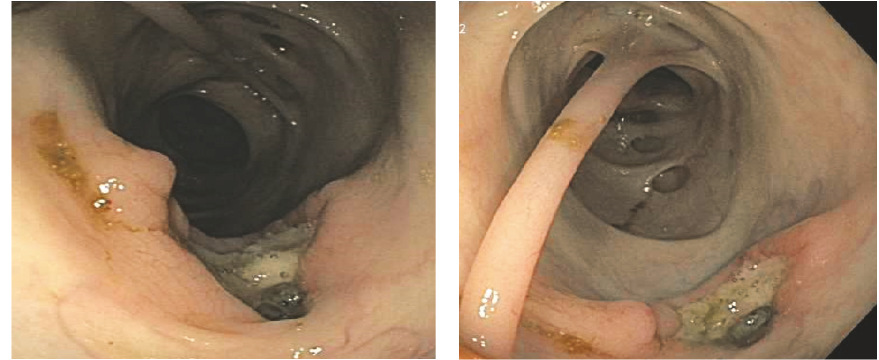
Figure 2: First colonoscopy: extensive diverticulosis and solitary ulcer in the sigmoid colon.